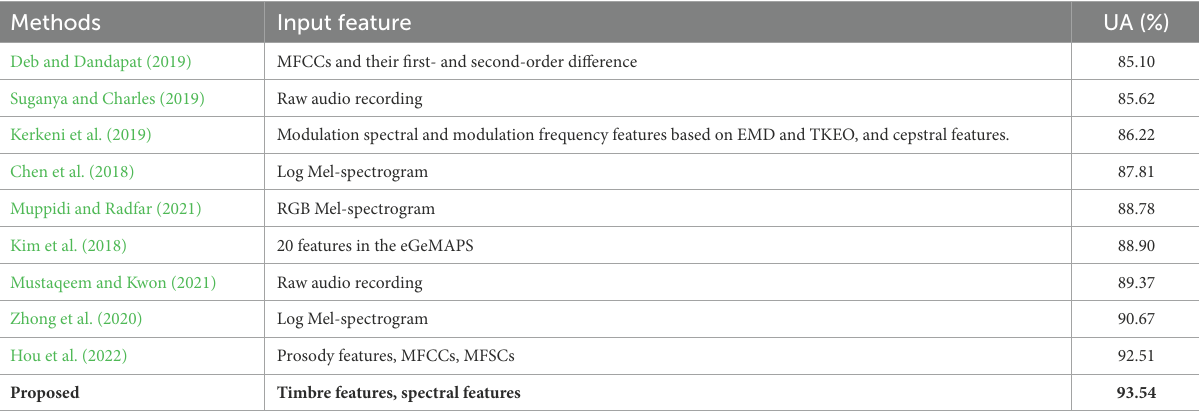
TABLE 4 Comparison of different SER methods on the EMO-DB